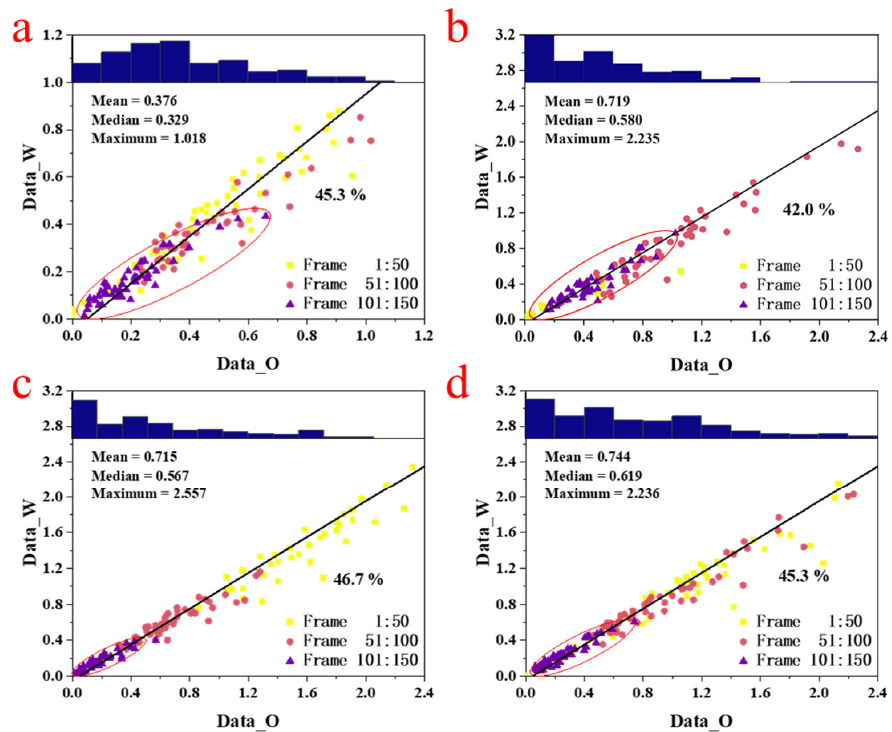
Figure 12. The result of the interframe difference method with an amplitude of 0.01 mL/min cases, ( a ) is 0 Hz case, ( b ) is 1 Hz case, ( c ) is 2 Hz case, ( d ) is 4 Hz case.